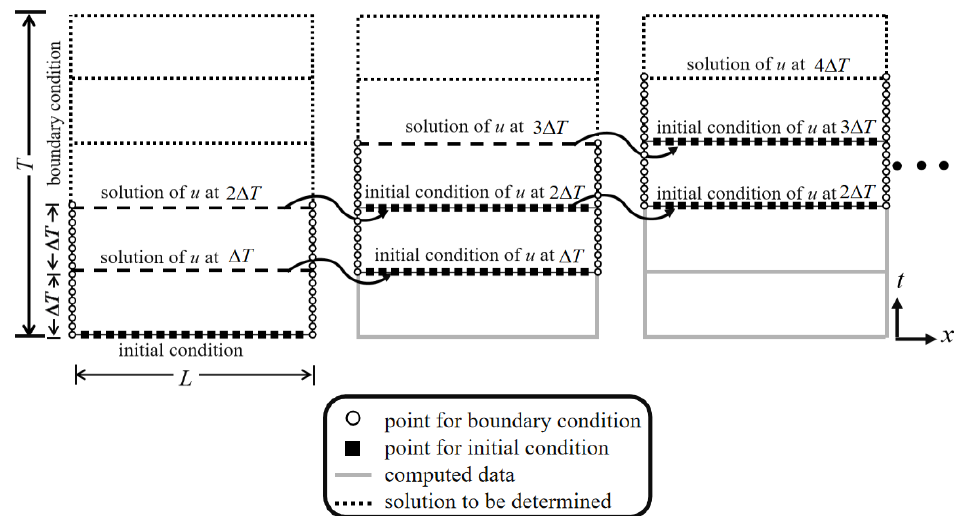
Figure 3. Illustration of the one-dimensional ST marching method.